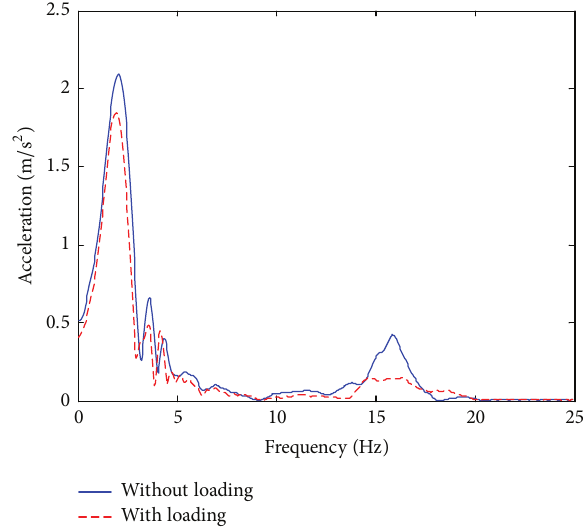
Figure 4: The FFT results of the vertical acceleration in the bounce test.